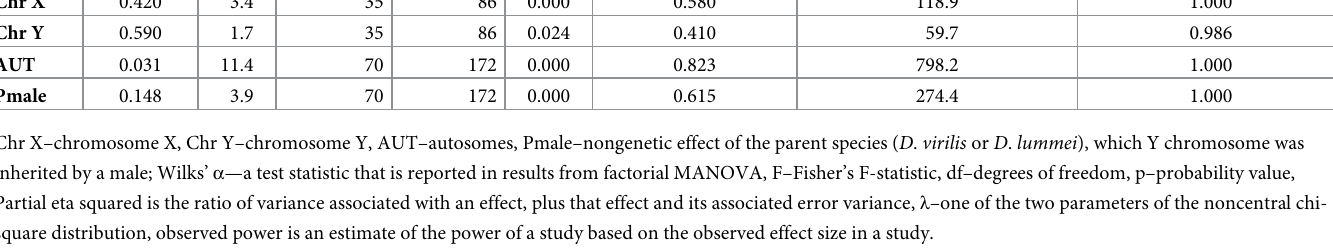
Table 5. Significant effects of chromosomes on the total variability of the traits of the shape of the copulative apparatus and the size of these effects. Wilks’